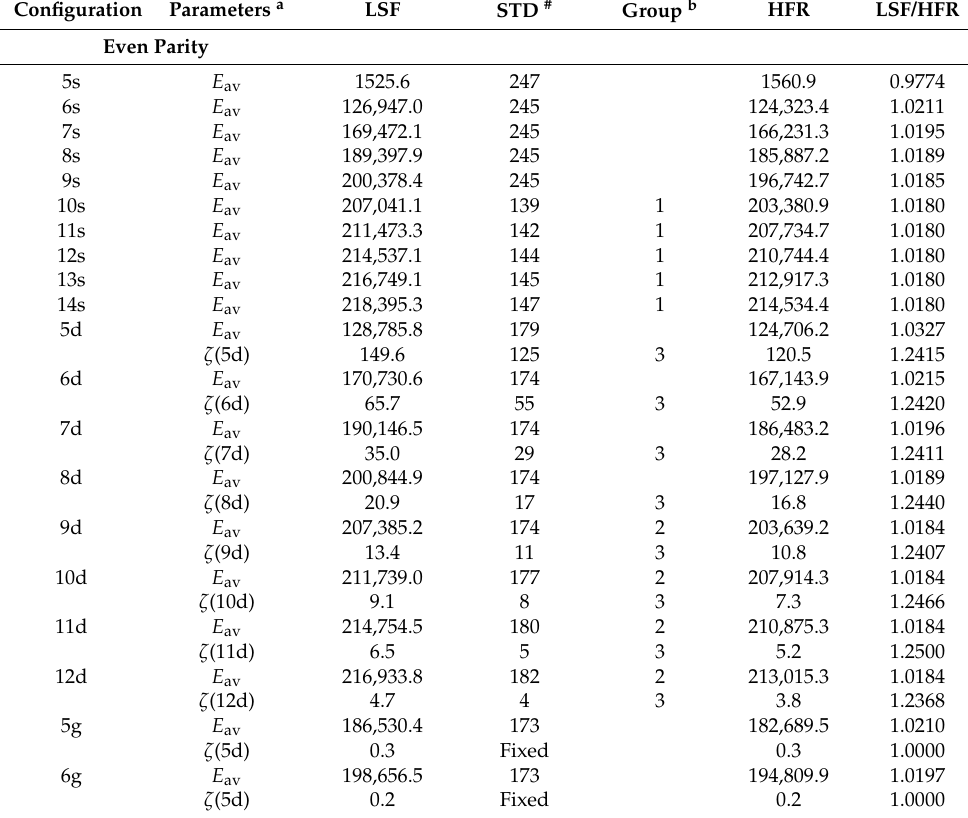
Table 1. Least Square Fitted (LSF) Energy Parameters (in cm − 1 ) for In III.